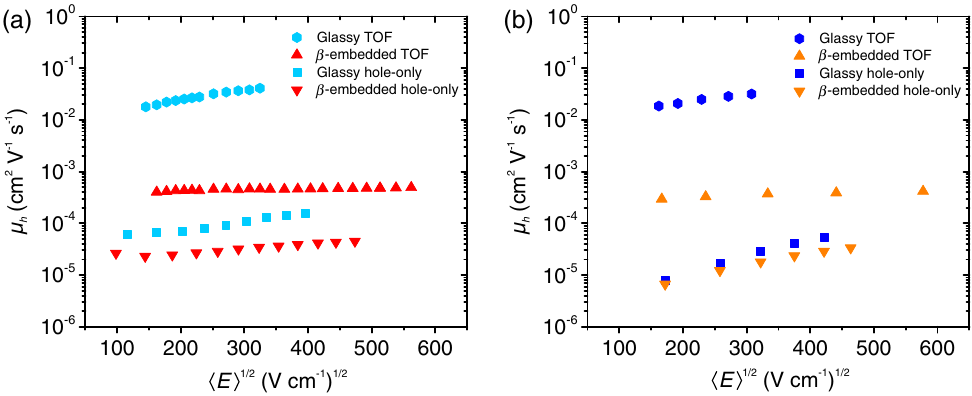
FIG. 11. (a) Summary of experimental values of HMW PFO μ at RT, as presented in Poole-Frenkel form. The μ values are h h reproduced from Fig. 2(b) for TOF and from Fig. 4 for impedance spectroscopy measurements on hole-only devices. (b) Summary of PFO μ values extracted from simulated response of TOF and hole-only dark J − V . The simulated TOF μ values are extracted by h h analyzing the simulated transients in the same way as for the experimental transients, while the simulated dc μ values for hole-only h devices are derived by multiplying the band μ by the ratio of free charge density to total (free and trapped) charge density at a mesh h point right next to the counter electrode along the 1D device